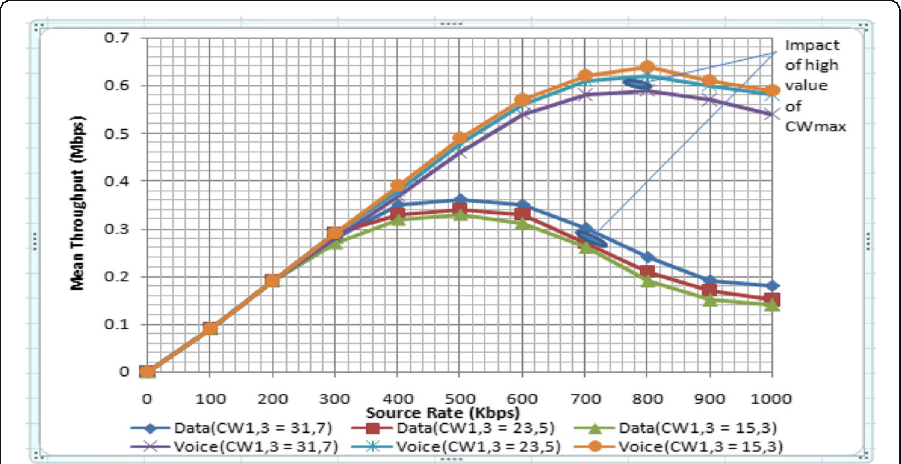
Fig. 13 Average throughput of BE and VO traffic at varied CW size versus source